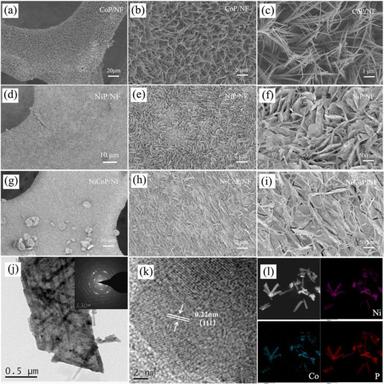
SEM images: (a-c) CoP/NF, (d-f) Ni/NF and (g-i) NiCoP/NF;(j-k) TEM and HRTEM image of NiCoP/NF nanoarray, inset: a SAED pattern, (l) Elemental mapping of NiCoP/NF nanoarray.